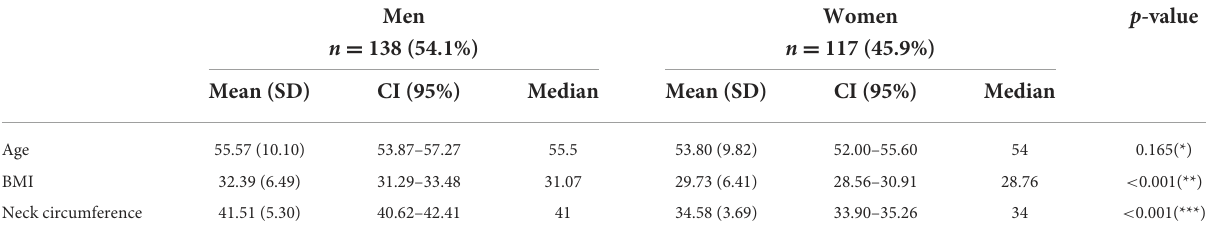
TABLE 1 Anthropometric variables.